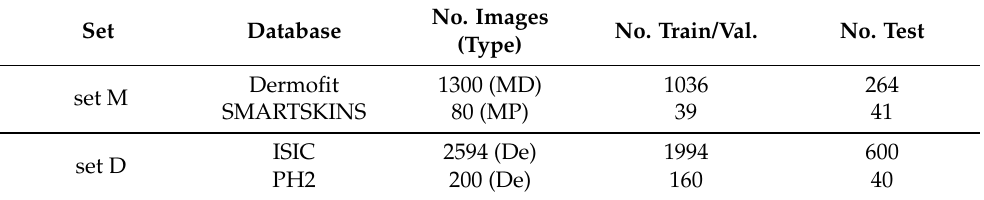
Table 1. Overview of available segmentation macroscopic and dermoscopic databases and separation into train/validation and test